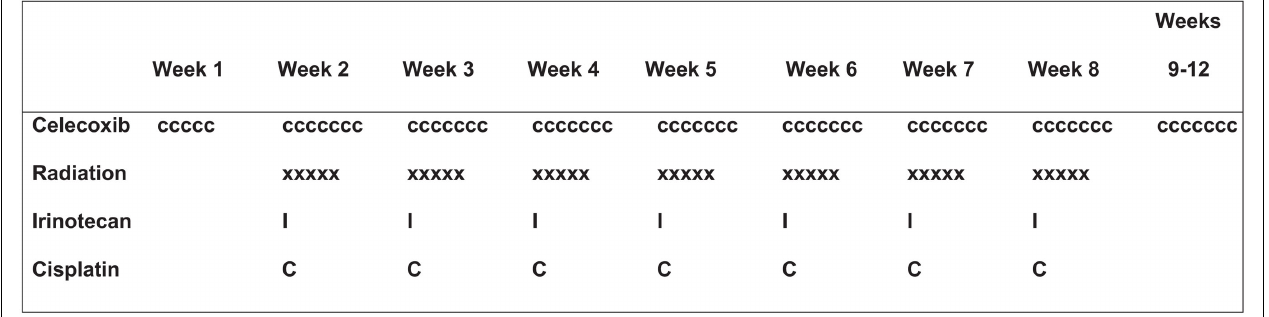
FIGURE 1 |Treatment schema. Radiation therapy was started after 5days of celecoxib. Cisplatin and irinotecan were administered once a week for 7weeks (weeks 2–8). Celecoxib was given orally beginning 5days before the